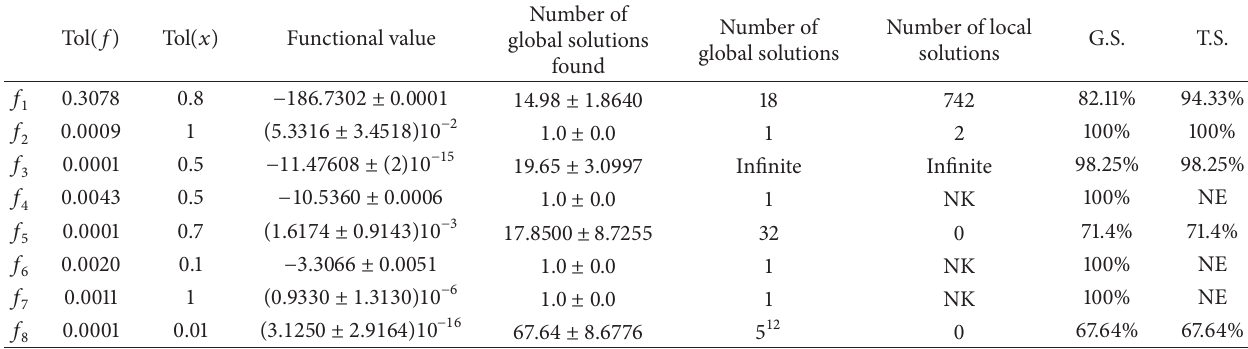
Table 3: Simulation results with maximum number of iterations as termination criterion based on 100 trials (NK stands for not known and NE for not estimated, i.e., if the number of local solutions is not known, then it is not possible to estimate TS).